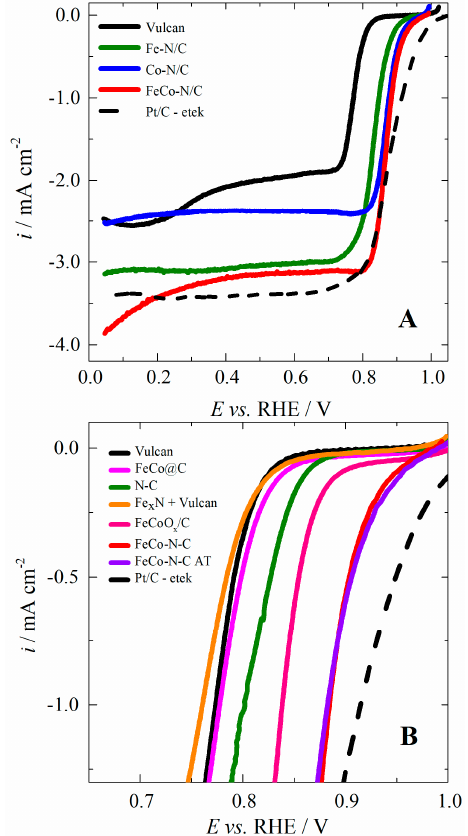
Figure 4. ( A ) Steady ‐ state polarization curves obtained for the ORR in O 2 ‐ saturated 1.0 mol L − 1 KOH electrolyte on Fe ‐ N ‐ C, Co ‐ N ‐ C, FeCo ‐ N ‐ C electrocatalysts, and ( B ) ORR at high potential domain on the synthesized structures taken as “blanks”: FeN x , FeCo@C, N ‐ C, and for FeCoO x /C, compared to that on FeCo ‐ N ‐ C and FeCo ‐ N ‐ C AT. The ORR curves obtained on Vulcan and Pt/C were included for comparison. Scan rate: 5.0 mV s − 1 . Rotation rate: 1600 rpm.